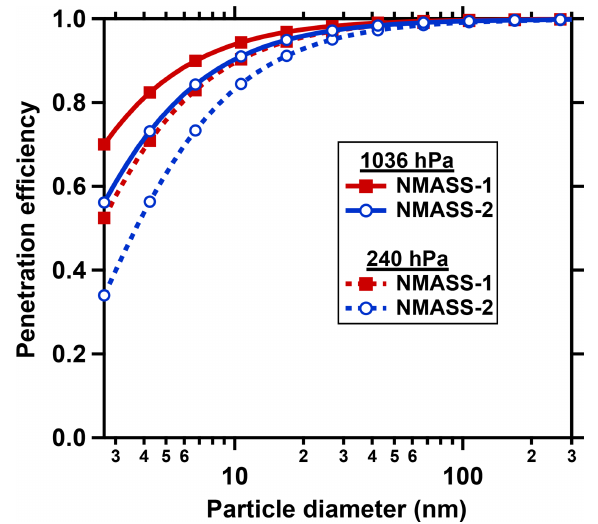
Figure 5. Calculated penetration efficiency for diffusing particles in the tubing between the inlet plenum and the NMASS-1 and NMASS-2 instruments for two pressures near sea level (1036hPa) and near aircraft maximum altitude (240hPa). Penetration effi- ciency for NMASS-2 is lower because the tubing between the inlet and the instrument is